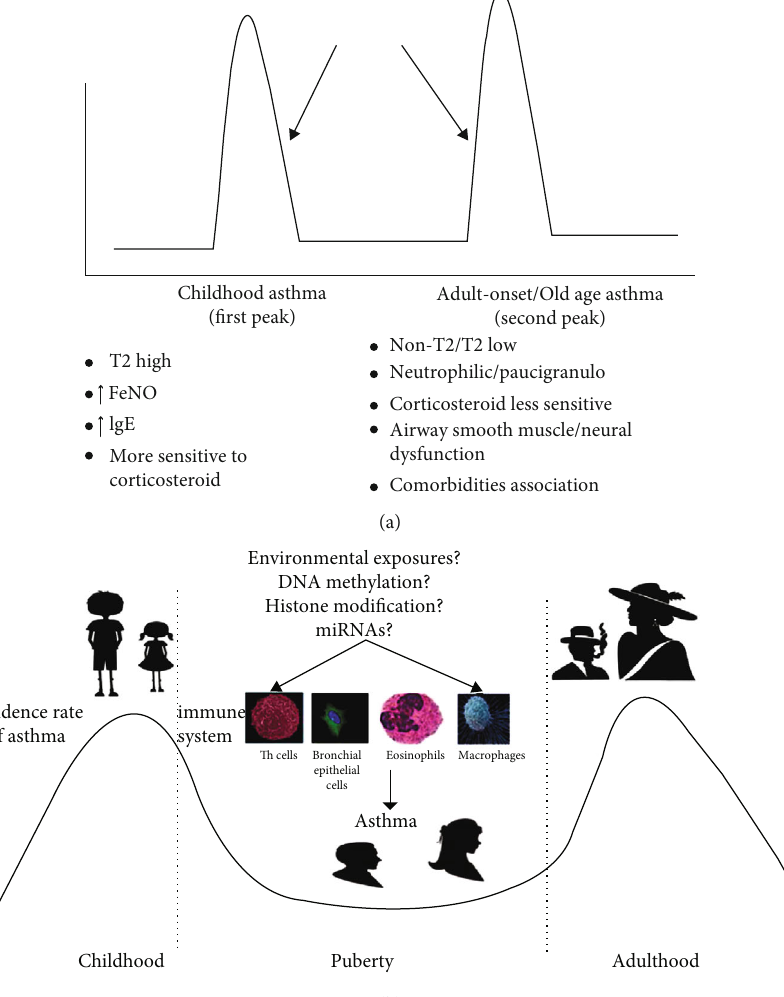
Figure 3: The two peaks of human asthma and the role of epigenetics in the cellular transformation of childhood asthma to adult-onset/old age asthma. (a) The two peaks of human asthma are childhood asthma ( ↑ IgE, ↑ eosinophils, FeNO, corticosteroid sensitive, and T2 high) and adult-onset/old age asthma (neutrophilic/paucigranulocytic, corticosteroid less sensitive, and non-T2 asthma) with airway smooth muscle or neural dysfunction, possible association with comorbidities [5, 6], and periods of remission in some cases. However, we should not forget that these pro fi les are not strictly age-limited (children and adults may have eosinophilic, neutrophilic, or even paucigranulocytic asthma with overlapping steroid response), and several other components of the immune, neuronal, and hormonal responses are also involved with asthma. (b) The two peaks of asthma (childhood asthma and adulthood as adult-onset/old age asthma). In general, there is male dominance in childhood asthma, with a shift to female dominance in later peak. Components of epigenetic mechanisms, as well as cells involved in asthma, are also shown, as their interaction is needed in asthma epigenetics. The long arrows in (a) show the possible point of commencement and involvement of epigenetic mechanisms, as we believe, in the cellular transformation of childhood asthma to adult-onset/old age asthma, although further epigenetic research is required in the future. IgE: immunoglobulin E; miRNAs: micro-RNAs; FeNO: fractional exhaled nitric